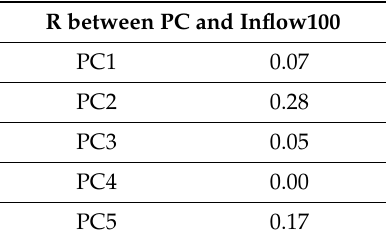
Table 7. Correlation coe ffi cients between components (PC1–PC5) and Inflow100. R between PC and